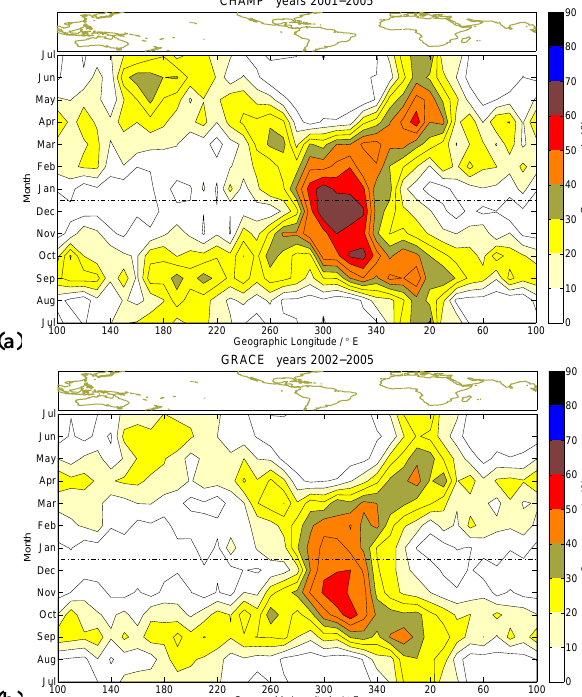
Fig. 5. The seasonal/longitudinal distribution of EPB occurrence rates from CHAMP PLP (top) and GRACE KBR (bottom) obser- vations during high solar activity years (2001–2005). Bin sizes are one month by 10 ◦ in longitude. The horizontal dashed line marks 1 January.